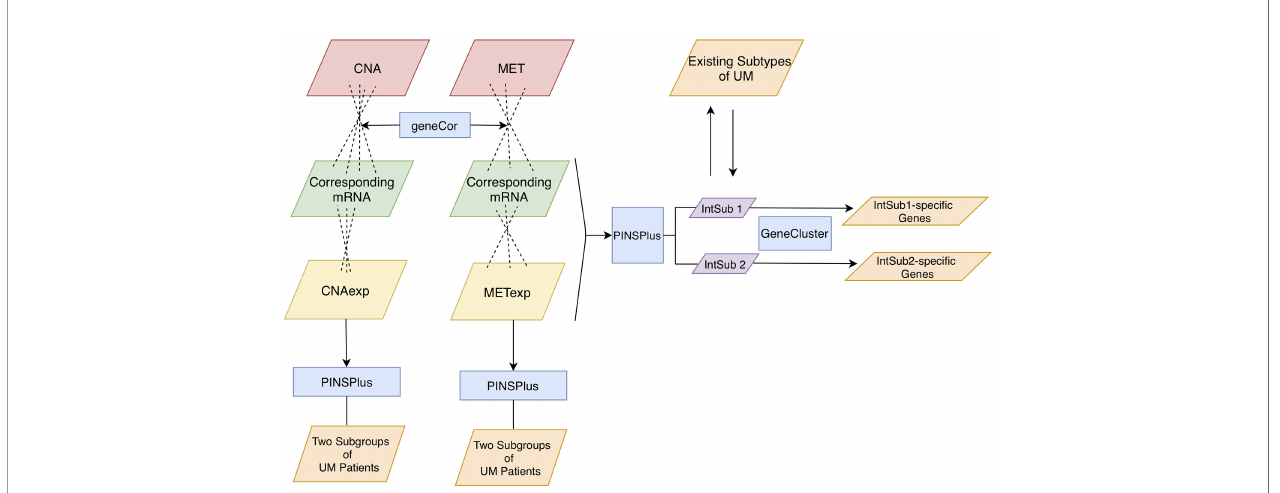
FIGURE 1 | Analysis pipeline. Firstly, we inputted CNA and MET datasets with their corresponding mRNA data to the function geneCor to identify a list of CNAexp and METexp genes, respectively. Then, PINPlus was used to extract different patient subgroups for individual CNAexp and METexp datasets and integration of CNAexp + METexp + mRNA data through single and integrated analyses, respectively. Finally, we discovered subtype-speci fi c genes within each identi fi ed integrated subgroup, IntSub1 and IntSub2, using the R package GeneCluster. UM, uveal